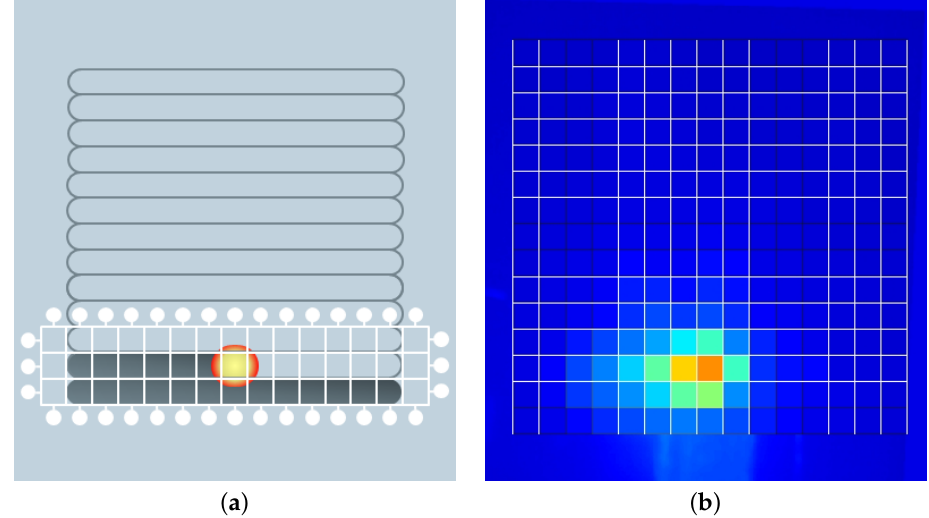
Figure 11. Illustration of spatial discretization of training data for single track case: ( a ) Schematic of specimen with grid (white circles represent fictional boundary grid points), ( b ) corresponding false color image with